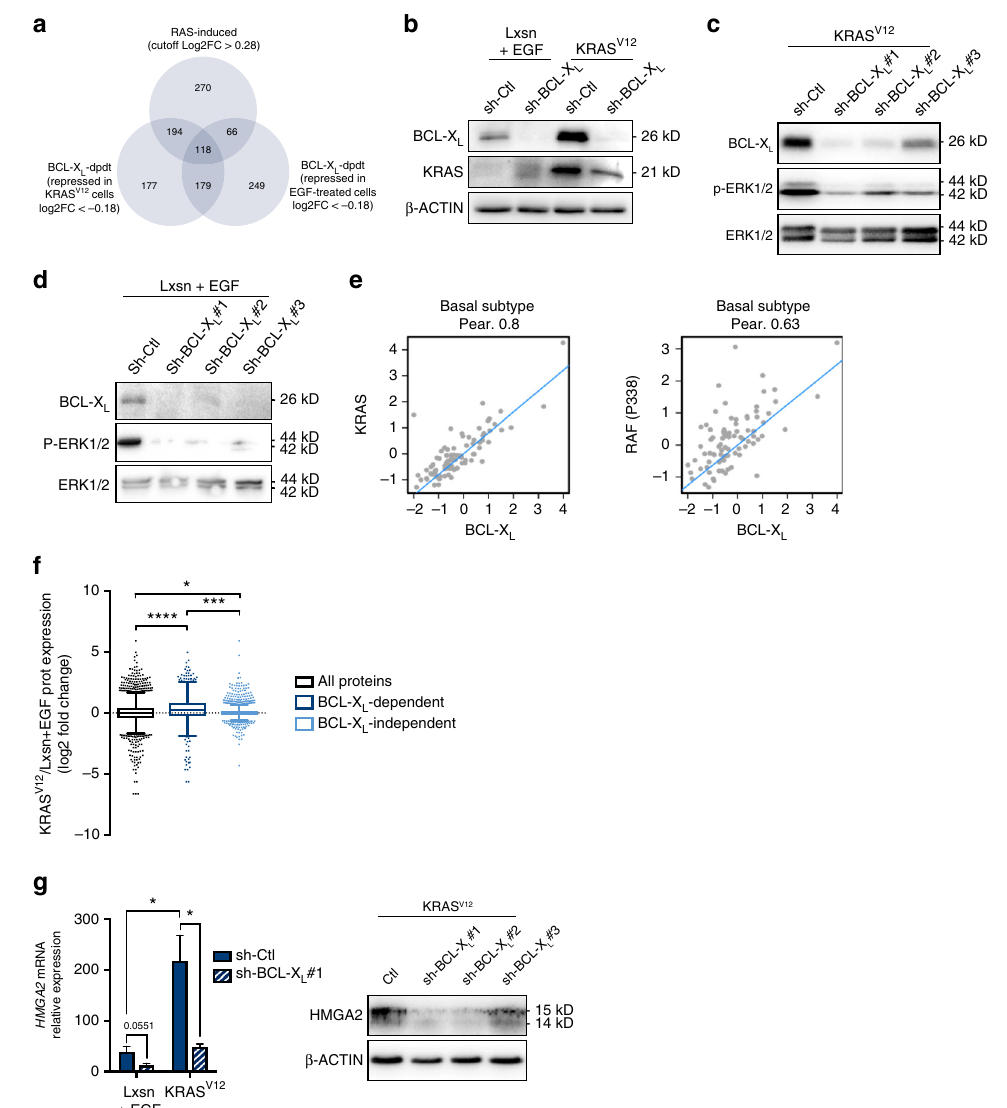
Fig. 3 BCL-X L contributes to MAPK activation to induce HMGA2 expression. a Venn diagram of repartition of protein expression variations in iTraq experiment. Applied cut-offs on log2 Fold Change are mentioned for each condition. RAS-induced proteins are those for which the log2 Fold Change is higher than 0.28 in MCF10A KRAS V12 sh-Ctl compared to MCF10A Lxsn sh-Ctl. BCL-X L -dpdt proteins are those for which the Log2 fold change is lower than − 0.18 in sh-BCL-X L compared to sh-Ctl in either EGF-treated MCF10A Lxsn cells (right) or MCF10A KRAS V12 cells (left). b – d Western blot showing KRAS, BCL-X L and/or p-ERK expressions in b MCF10A Lxsn and KRAS V12 cells, c MCF10A KRAS V12 cells 72 h after sh-BCL-X L and d MCF10A Lxsn cells 72 h after sh-BCL-X L (in presence of 20 ng ml − 1 EGF in MCF10A Lxsn media). e Correlations between BCL-X L protein expression and KRAS protein expression (left) or p338RAF protein expression (right) in basal subtype tumour samples. Quanti fi ed expression of BCL-X L , KRAS and p338RAF from RPPA data were examined for correlation using Pearson ’ s (Pear.) analysis. The results shown here are based upon data generated by the TCGA Research Network: http://cancergenome.nih.gov/. f Box & Whiskers representation of KRAS V12 vs. Lxsn log2 Fold Change protein expression (Tukey representation, unpaired t -test with equal SD). Black box represents log2FC for all proteins, dark blue box represents KRAS vs. Lxsn log2FC of BCL-X L -dependent proteins (as de fi ned above), light blue box represents KRAS vs. Lxsn log2FC of BCL-X L -independent proteins (with sh-BCL-X L vs. sh-Ctl log2FC < − 0.18 or > 0.18 in KRAS V12 background). g qPCR analysis of HMGA2 mRNA in MCF10A Lxsn and KRAS V12 cell lines infected with sh-BCL-X L during 72 h (in presence of 20 ng ml − 1 EGF in MCF10A Lxsn media). Mean and SEM of 3 independent experiments are represented as relative quantity of mRNA normalised to the mean of RPLP0 , RPS18 and GAPDH relative expression (two-tailed unpaired t-test). Western blot analysis showing HMGA2 expression in MCF10A Lxsn cell line infected with sh-BCL-X L during 72